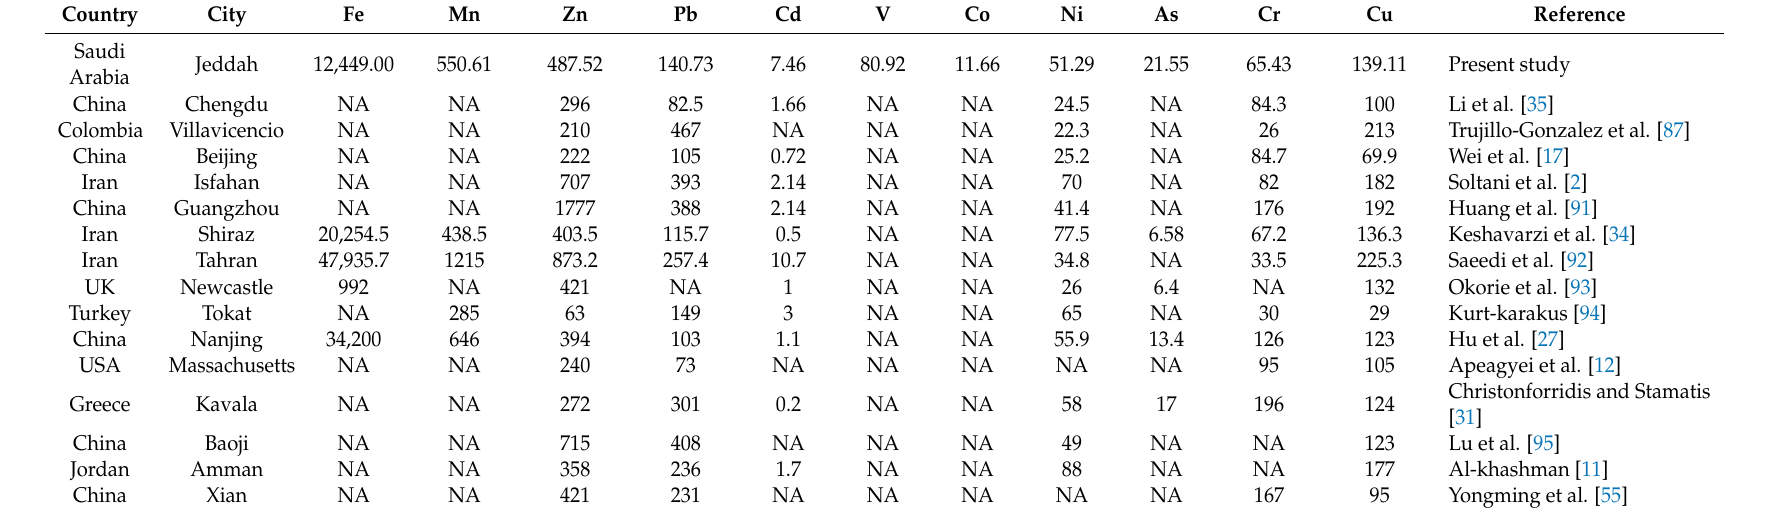
Table 4. Heavy metals concentrations (mg/kg) in urban road dusts of different cities around the